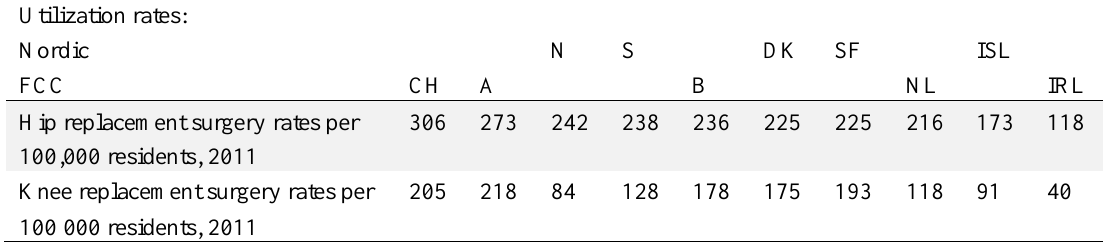
Utilization rates for hip and knee replacements in Nordic countries (upper row) and in FCC countries (lower